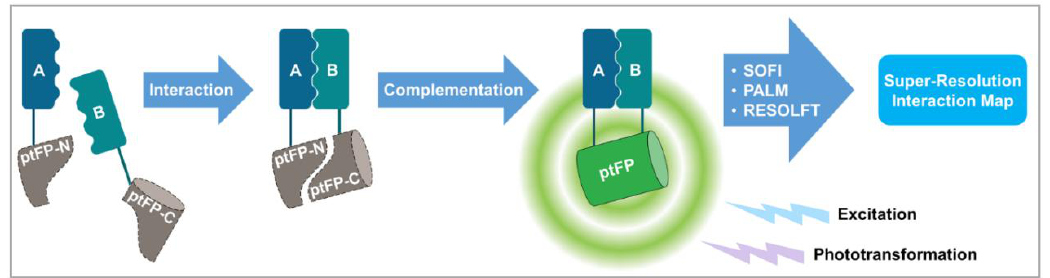
Figure 1. Principle of super-resolution imaging of protein-protein interactions with BiFC of phototransformable fluorescent proteins (ptFPs). Protein A is fused to an N-terminal fragment of the ptFP (ptFP-N); and protein B is fused to the complementary C-terminal fragment (ptFP-C). When protein A and B interacts, ptFP-N and ptFP-C reconstitute. Following chromophore maturation, fluorescently labeled interaction loci can be excited and phototransformed for super-resolution detection with SOFI, PALM, or RESOLFT. The choice of SRM technique depends on photoactivation, photoconversion, or photoswitching property of FP used in each study.